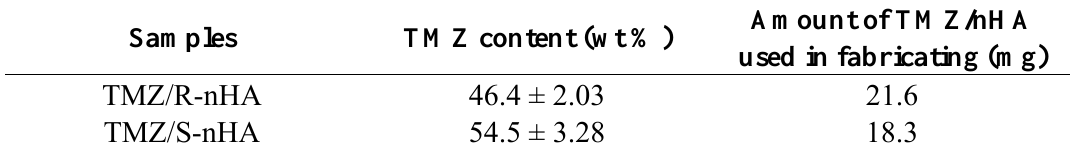
Table 1. The content of temozolomide (TMZ) in the TMZ/nHA and amount of TMZ/nHA used in